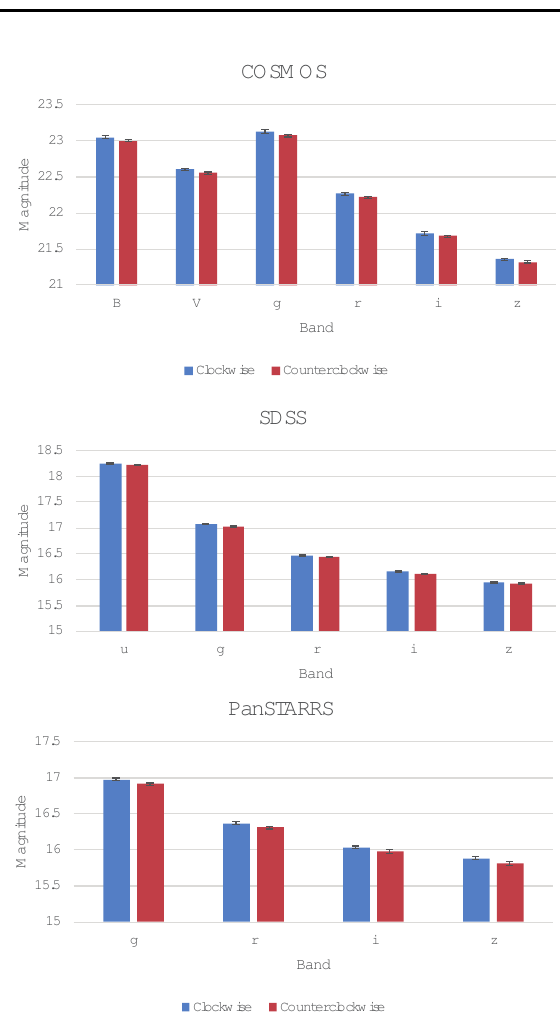
Figure 2. Mean magnitude and standard error of clockwise and counterclockwise galaxies in the different bands in COSMOS, SDSS and